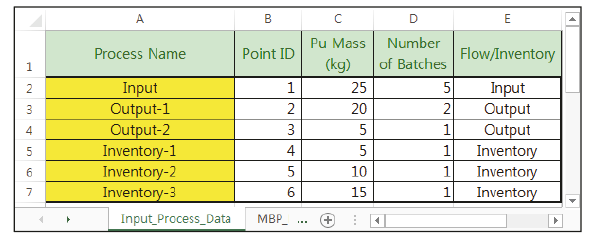
Figure 1: Example of input format (Excel file) for configuration of simple process model.